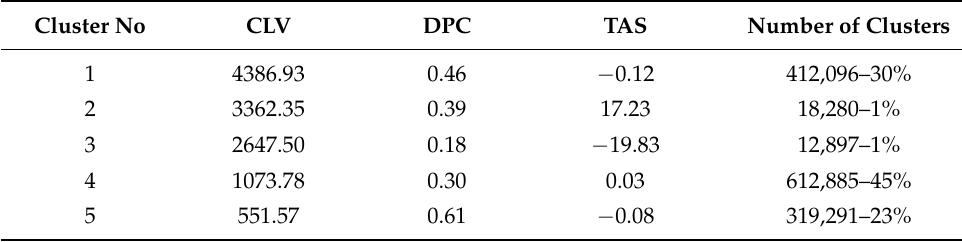
Table 7. Cluster